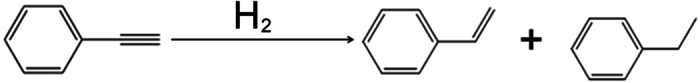
Hydrogenation of phenylacetylene.